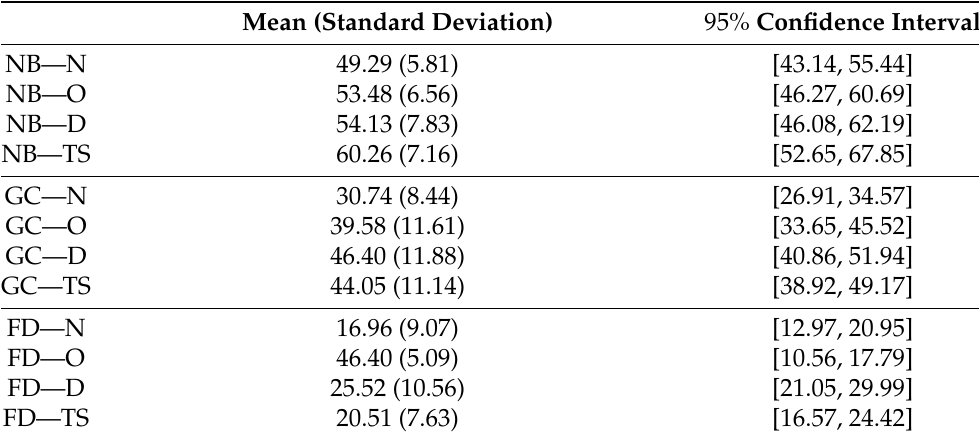
Table 2. The mean, standard deviation, and 95% confidence intervals of the Post-Pre difference of the SSQ scores for each condition (N—Nausea; O—Oculomotor; D—Disorientation; TS—Total Score); (conditions: NB—No Blur; GC—Unity Blur; FD—Ours).